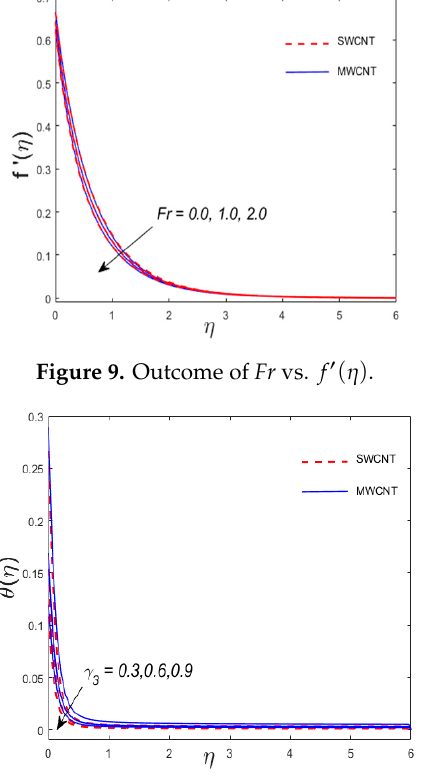
Figure 10. Outcome of γ 3 vs. θ ( η ) .